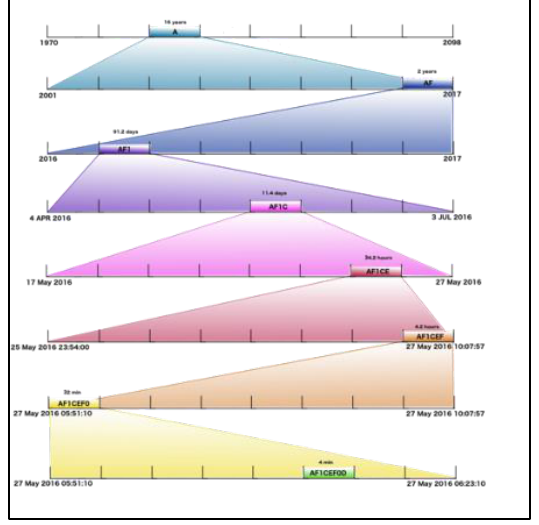
Figure 6. Timehashing Methodology Figure 7. Six Iterations of the Hilbert SFC